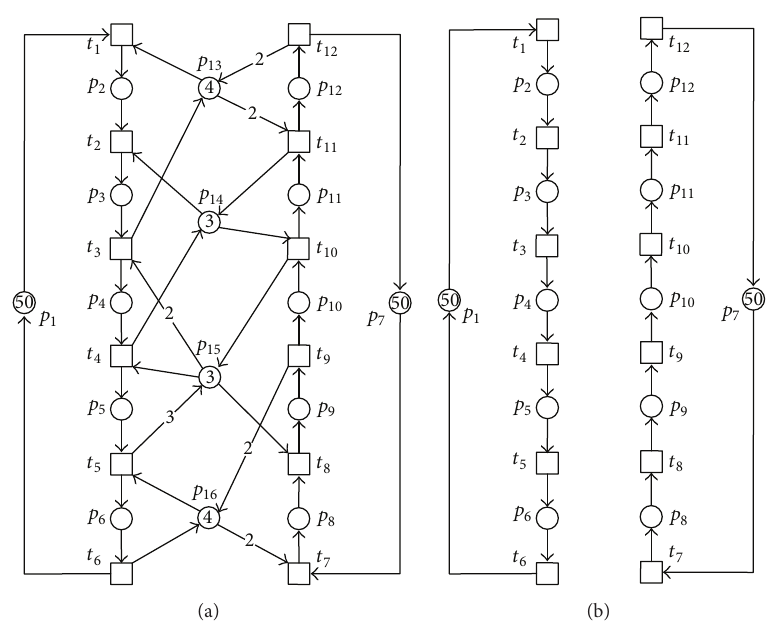
Figure 1: (a) An S 4 PR model (𝑁,𝑀 0 ) ; (b) Processes 1 and 2